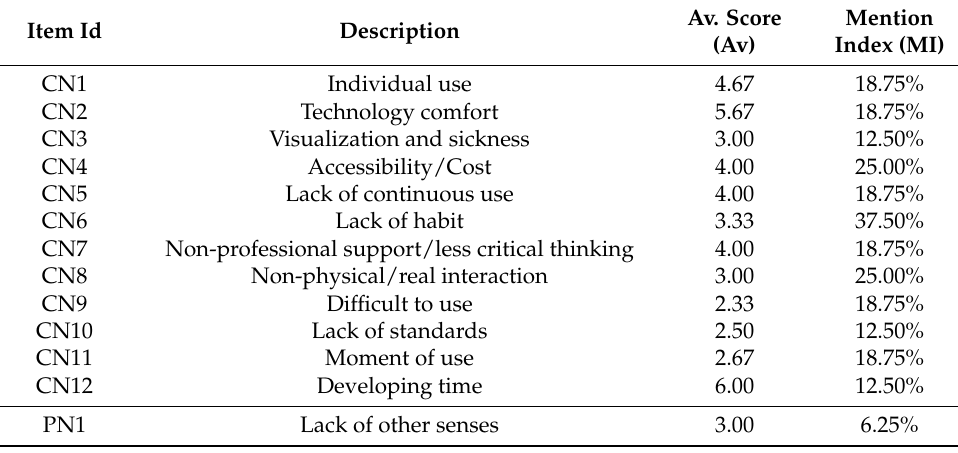
Table 6. BLA negative elements of HMD-VR systems identified.